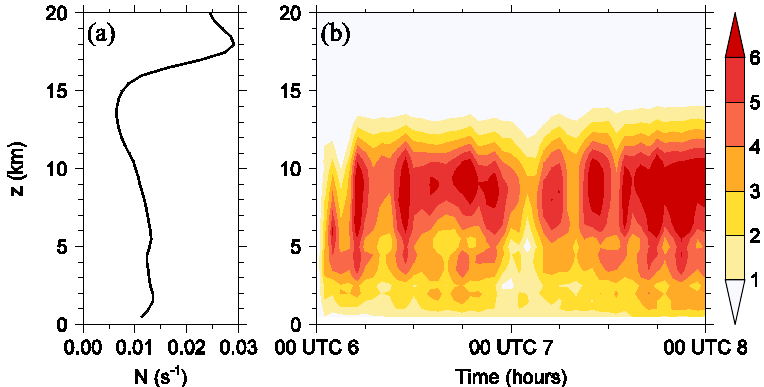
Figure 2. ( a ) Profile of the basic-state Brunt-Väisälä frequency and ( b ) time-height distribution of the diabatic heating rate averaged over the main convective region (K h −1 ).